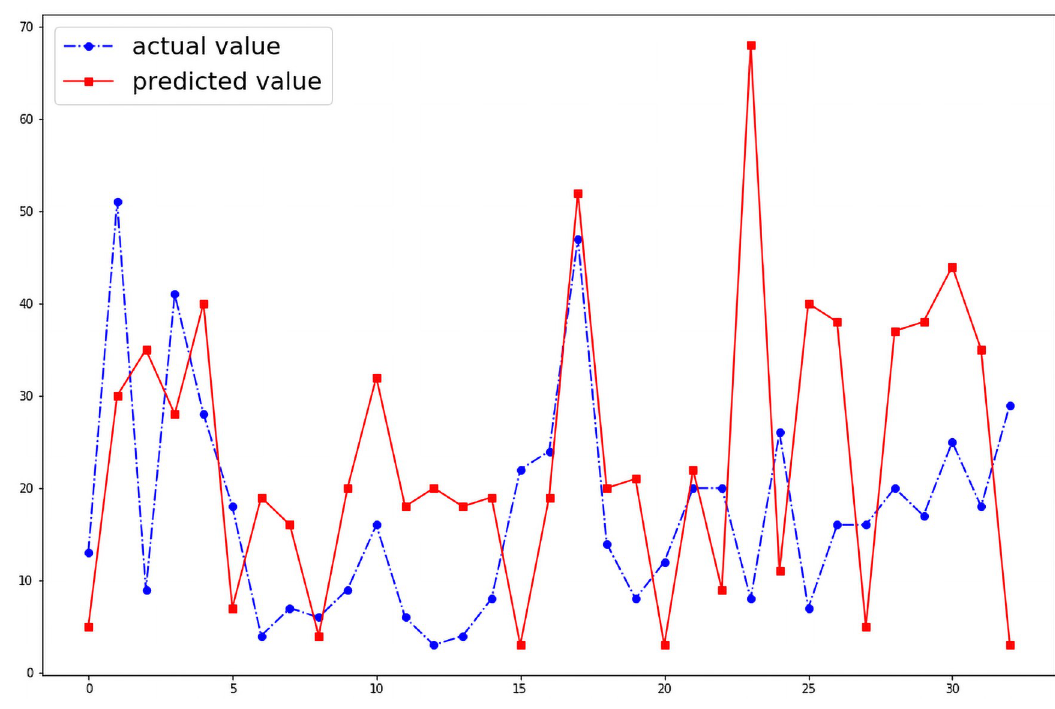
Fig 5. With optimization (RMSE: